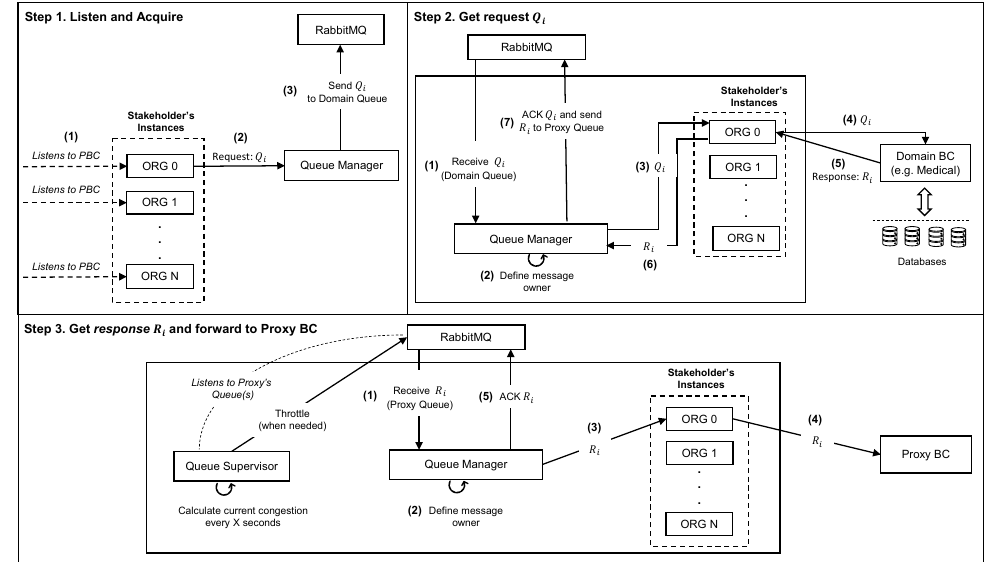
Figure 6. Inter Blockchain API